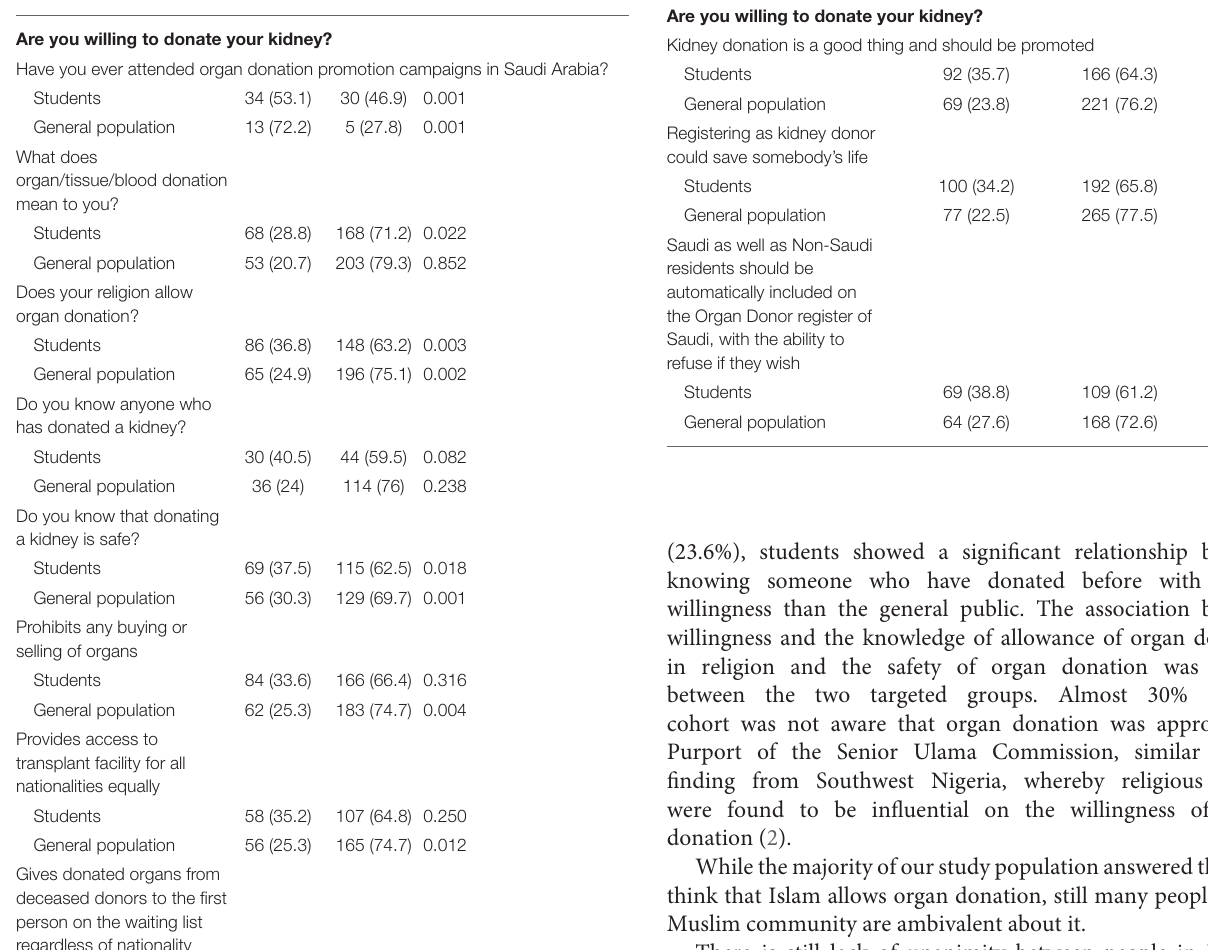
TABLE 6 | Correlation between knowledge and willingness. Knowledge about kidney donation